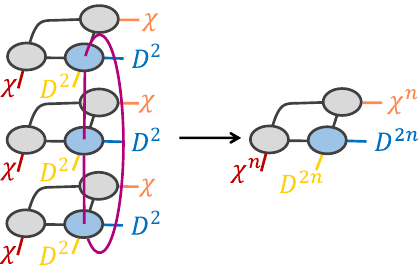
FIG. 2. Contracting n copies of the density matrix (here n = 3) to get the n th RDM moment can be done site by site as in the figure. The exponential dependence of the dimension of ρ A on N A turns into a linear dependence. However, a prohibitive exponential dependence on n emerges